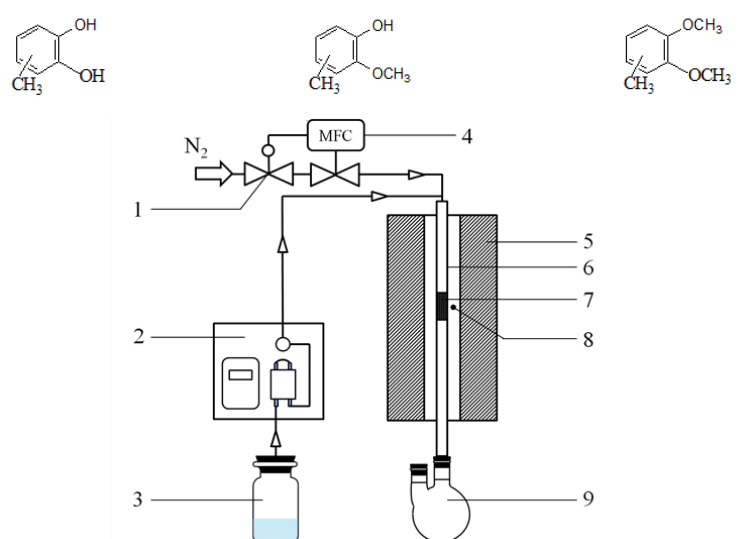
Figure 1. Diagram of catalyst evaluation system. 1. Stable-Flow valve; 2. Advection pump; 3. Reac- tion mixture; 4. Mass flow controller; 5. Tube furnace; 6. Reaction tube; 7. Catalyst bed; 8. Thermo- electric couple; 9. Receiving flask.